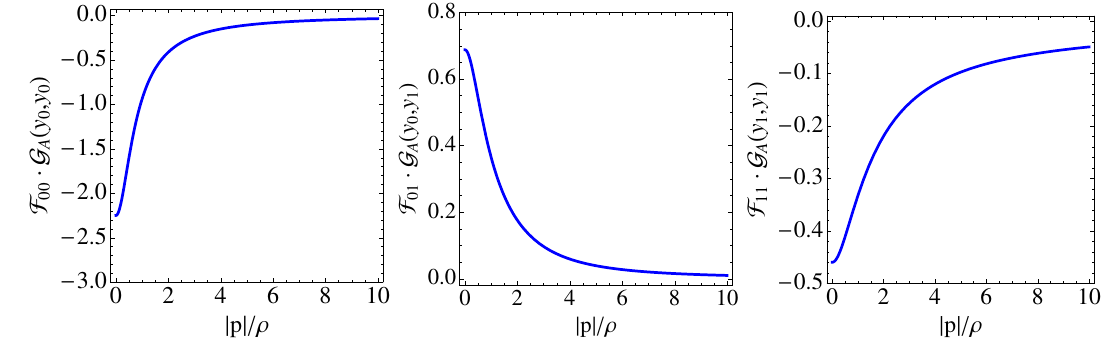
Figure 3 . Plots of F 00 · G A ( y 0 , y 0 ; | p | ) (left panel), F 01 · G A ( y 0 , y 1 ; | p | ) (middle panel) and F 11 · G A ( y 1 , y 1 ; | p | ) (right panel) as a function of | p | /ρ . We have used A 1 = 35 in all panels and assume space-like momenta p 2 < 0